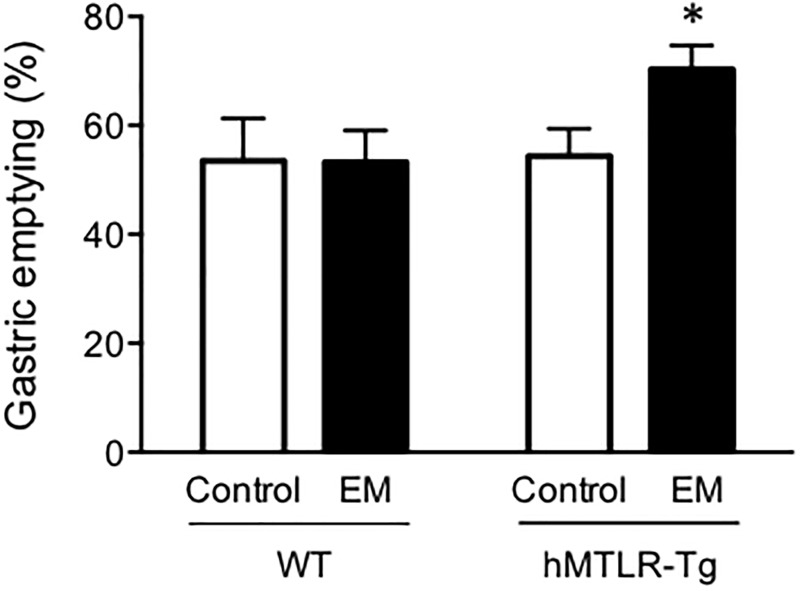
Effect of erythromycin on gastric emptying in WT and hMTLR-Tg mice.Animals were orally administered phenol red-containing CMC and the concentration of phenol red in the gastric content was determined 10 min later. Erythromycin (EM; 10 mg/kg) was injected intraperitoneally 20 minutes before phenol red administration. Data are presented as the mean ± SEM for 6 animals. *Statistically significant difference from control (vehicle alone) at P < 0.05.